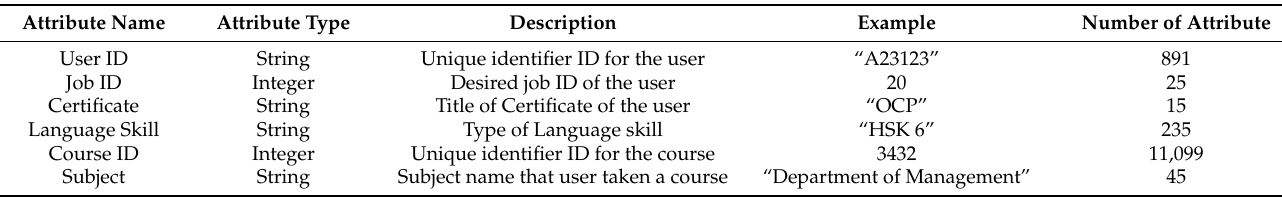
Figure 2. Dataset collection process. Table 1. Statistics of the datasets and